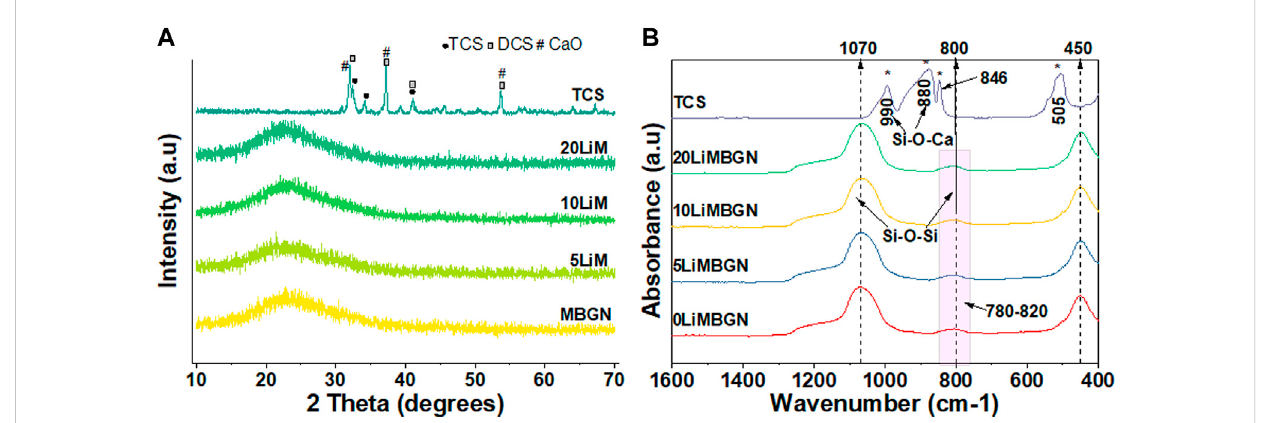
FIGURE 3 Comparative XRD patterns (A) and FTIR spectra (B) of as synthesized particles. MBGNs are seen to be amorphous. Peaks marked with asterisks at 880 cm − 1 , 990 cm − 1 , 846 cm -1 and 505 cm -1 (B) are analyzed in the text.